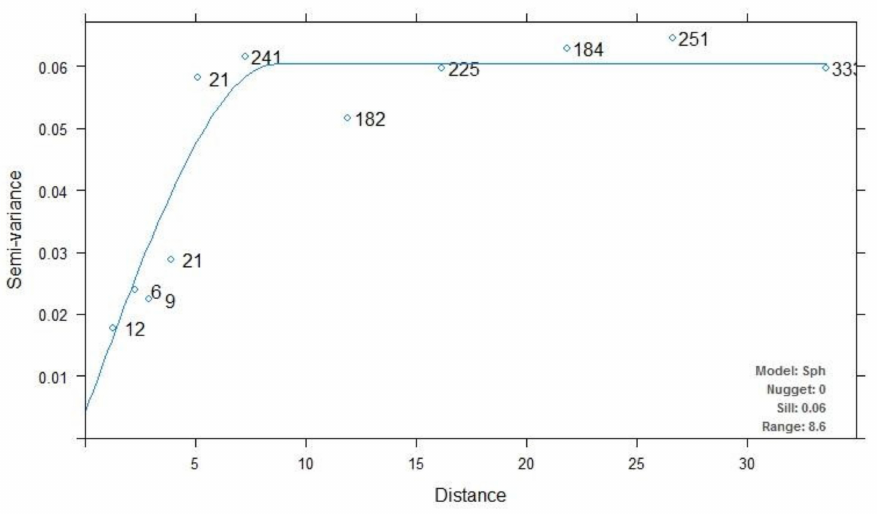
Figure 5. Experimental variogram and fitted variogram model.